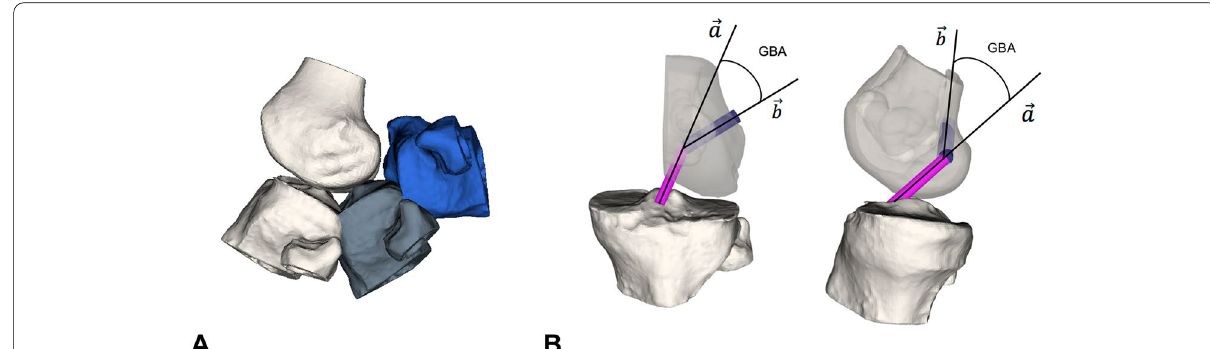
Fig. 4 Schematic illustration of different flexion grades and measurement of graft bending angle (GBA). GBA: Graft bending angle. The tibia moved around the femur for 0, 30, 60, 90, 120° of flexion ( A ). 3D GBA between ACL (pink) and femoral tunnel (violet) illustrated from an anterior and lateral view ( B